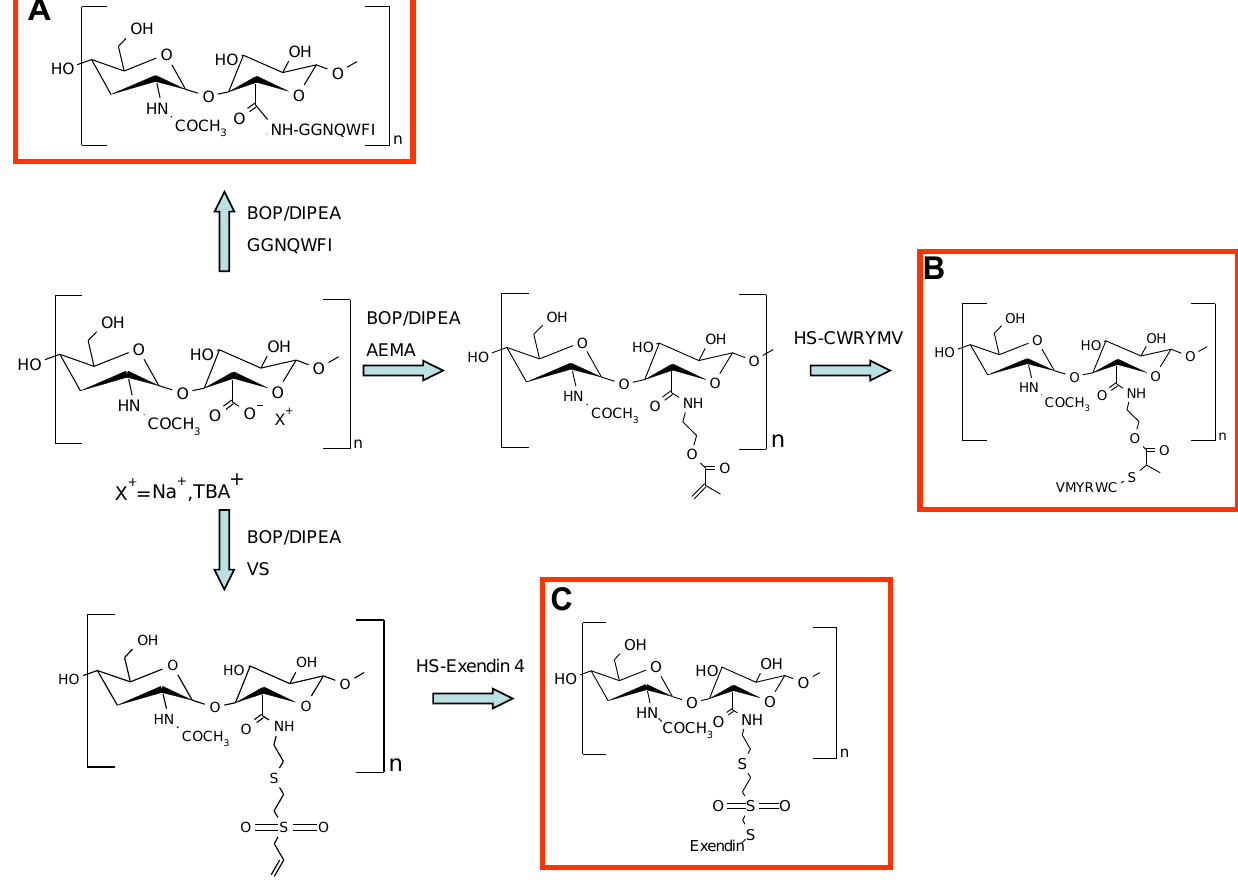
Figure 10. Schematic representation of different HA activation and peptide